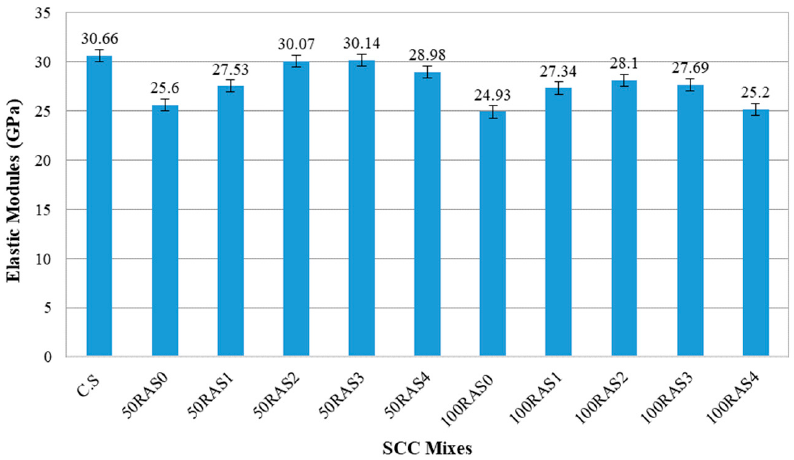
Figure 11. Elastic modules result of SCC mixes .